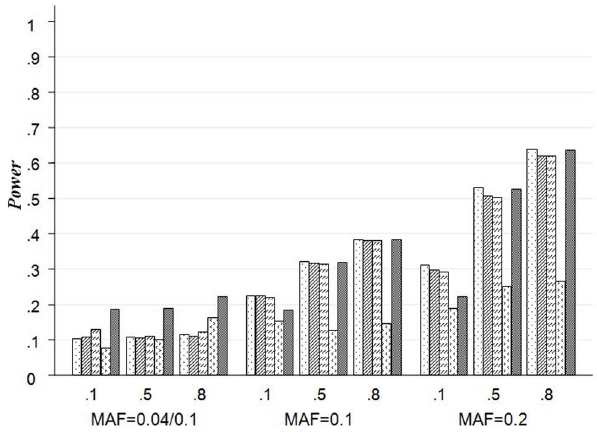
Figure 2. Test of Power for LKM, PCA and wPCA in Scenarios A4–A6. The plot shows the powers (y-axis) based on virtual datasets with single causal SNP of each method over the different LD and MAF structures (x-axis) with 20 SNPs. The first line of x-axis represents LD, and the bottom line is MAF.